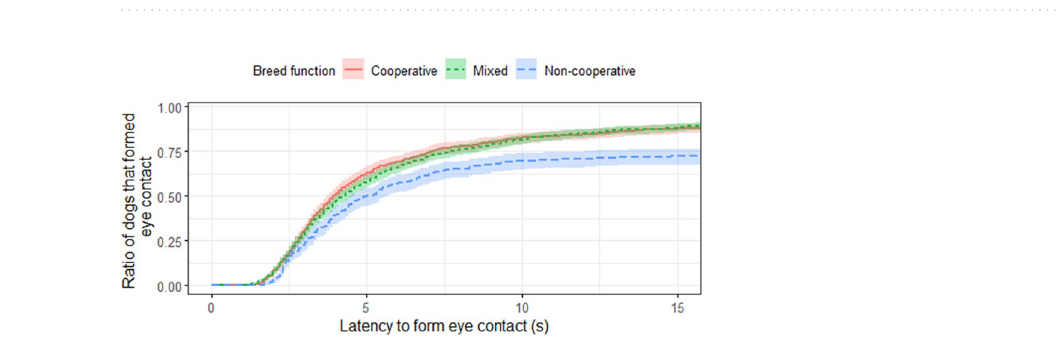
Figure 3. Survival plot for 125 dogs in three head shape groups. Cephalic index was a continuous value in the analysis, but the sample was divided into three groups at the 0.33 and 0.67 quartiles for visualisation purposes only . On the X axis the latency to form eye contact can be read (for visualisation purposes, data are censored at 15 s), while on the Y axis the ratio of dogs that formed eye contact with the experimenter is displayed.